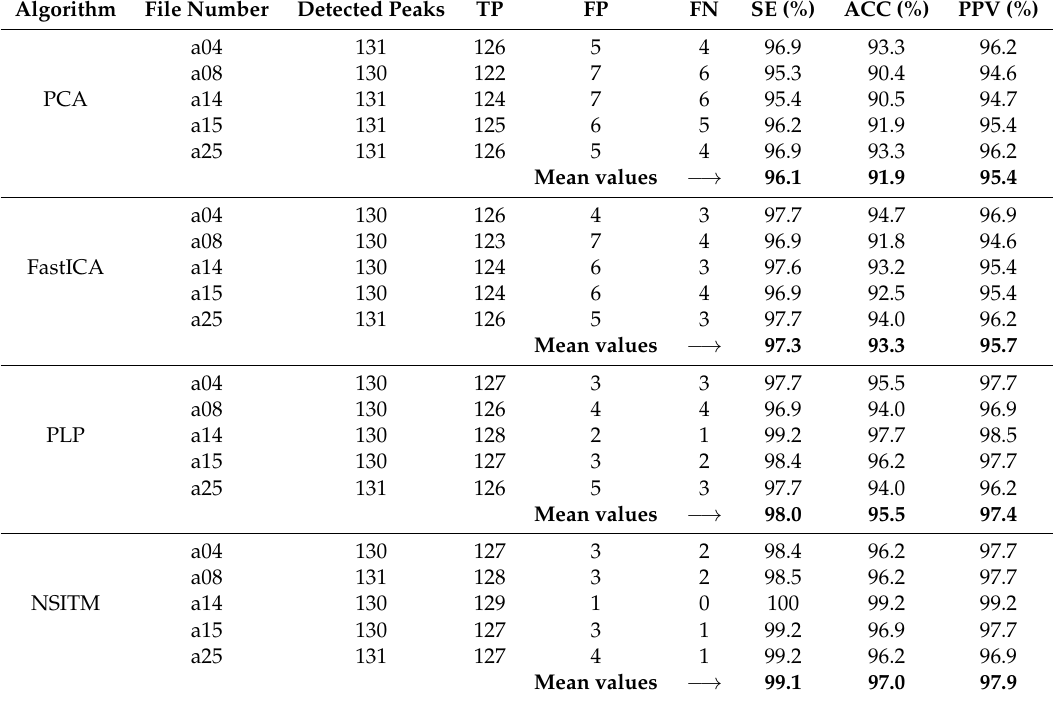
Table 5. Statistical measures on data collected from Physionet/Computing in Cardiology Challenge 2013 database obtained by the proposed NSITM, PCA, FastICA, and PLP